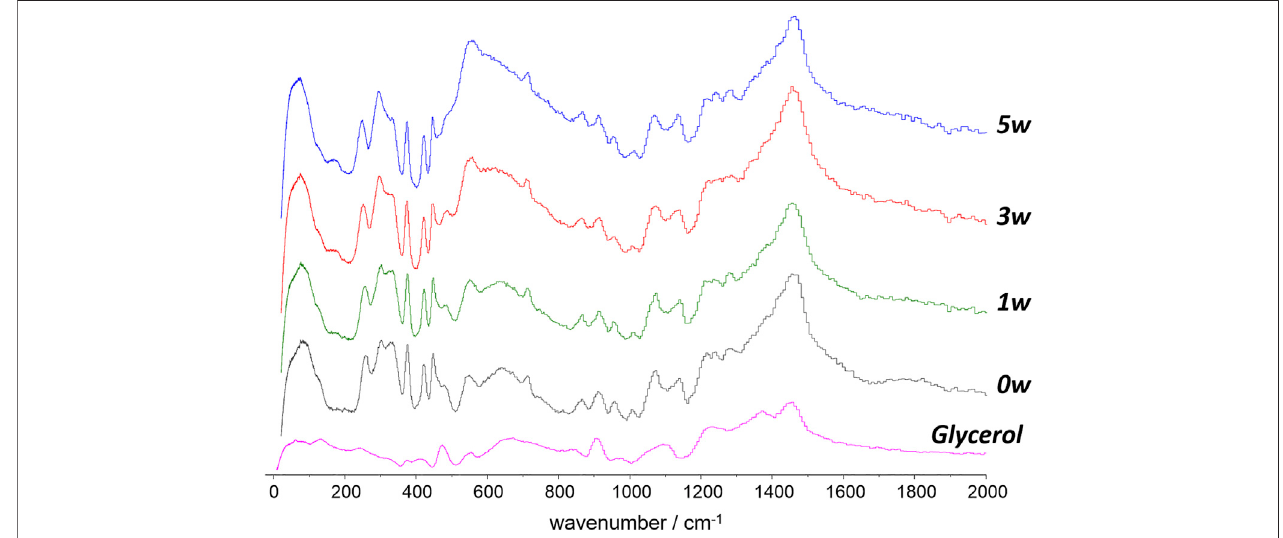
FIGURE 7 | INS spectra of glycerol and the ChCl:glycerol eutectic mixture with increasing water content, in the 0 – 2000 cm − 1 range. From bottom to top: glycerol, DES:water molar ratio of 1:0 ( ca . 0.6% wt, 0w), 1:1 ( ca . 5.3% wt, 1w), 1:3 (ca. 14.3% wt, 3w), and 1:5 (ca. 21.7% wt, 5w).